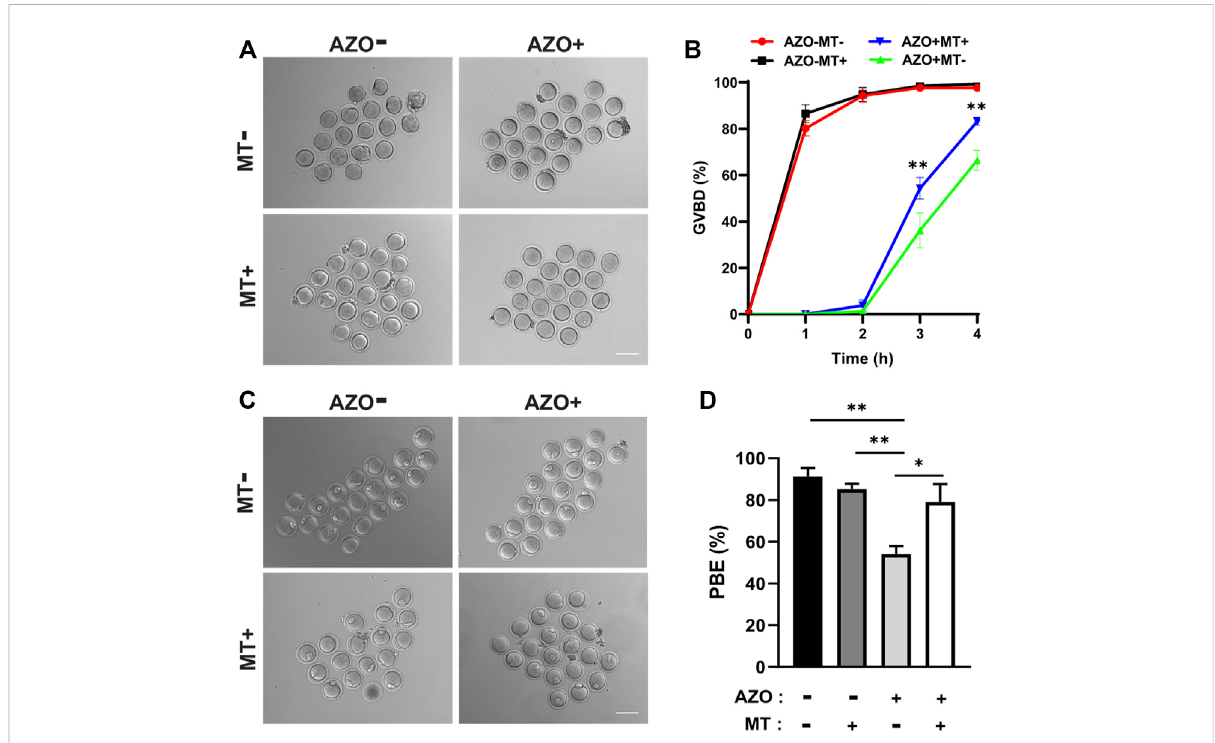
Melatonin rescuesPBEimpairedbyAZOexposure.Oocyteswerematuredintheabsence ( − )orpresence(+)ofAZOandmelatonin(MT)during meiotic maturation. (A) Representative images of oocytes at 4 h of culture with different treatments following IBMX release. Scale bar, 100 μ m. (B) The percentage of GVBD is expressed as mean ± SEM from two independent experiments. (C) Representative images of oocytes at 16 h of culture with different treatments following IBMX release. Scale bar, 100 μ m. (D) After 16 h of culture with different treatments, the percentage of polar body extrusion was expressed as mean ± SEM from three independent experiments. * p < 0.05, ** p <